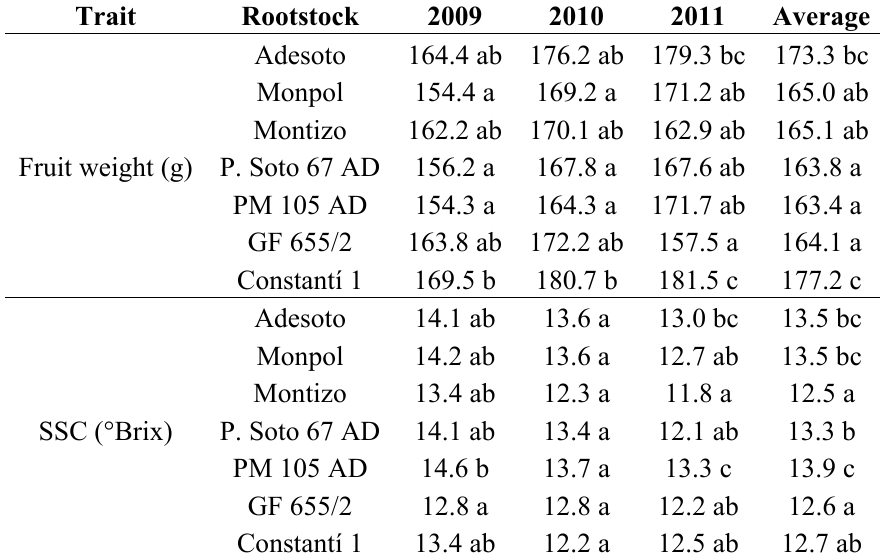
Table 2. Influence of different plum rootstocks on fruit weight, soluble solids content (SSC), flesh firmness and ripening index of “Catherine” peach fruits in the tenth (2009), eleventh (2010) and twelfth (2011) year after